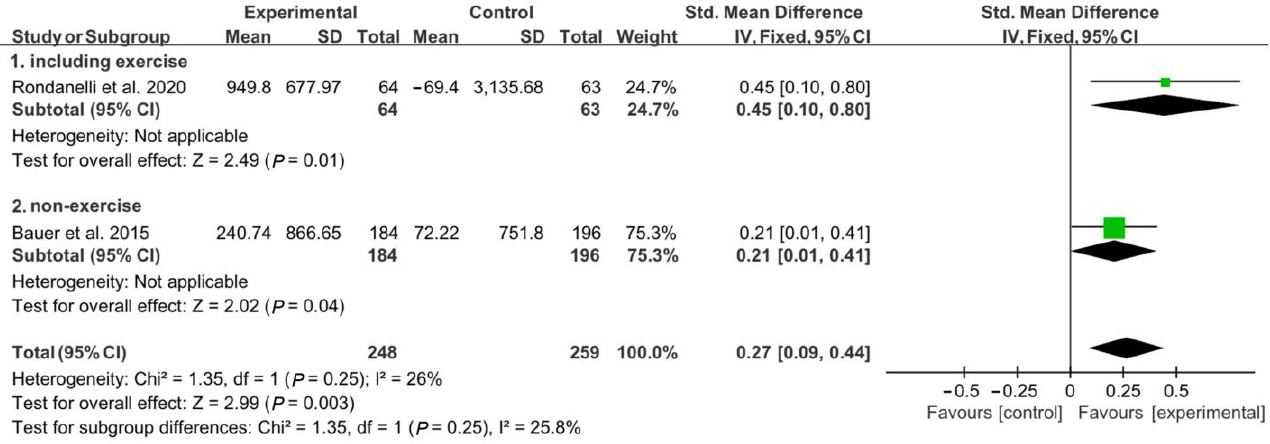
Figure 3. Forest plot showing the results of appendicular muscle mass after use of whey protein, leucine, and vitamin D in patients with sarcopenia [19,21]. Numbers in bold indicate analysis results.